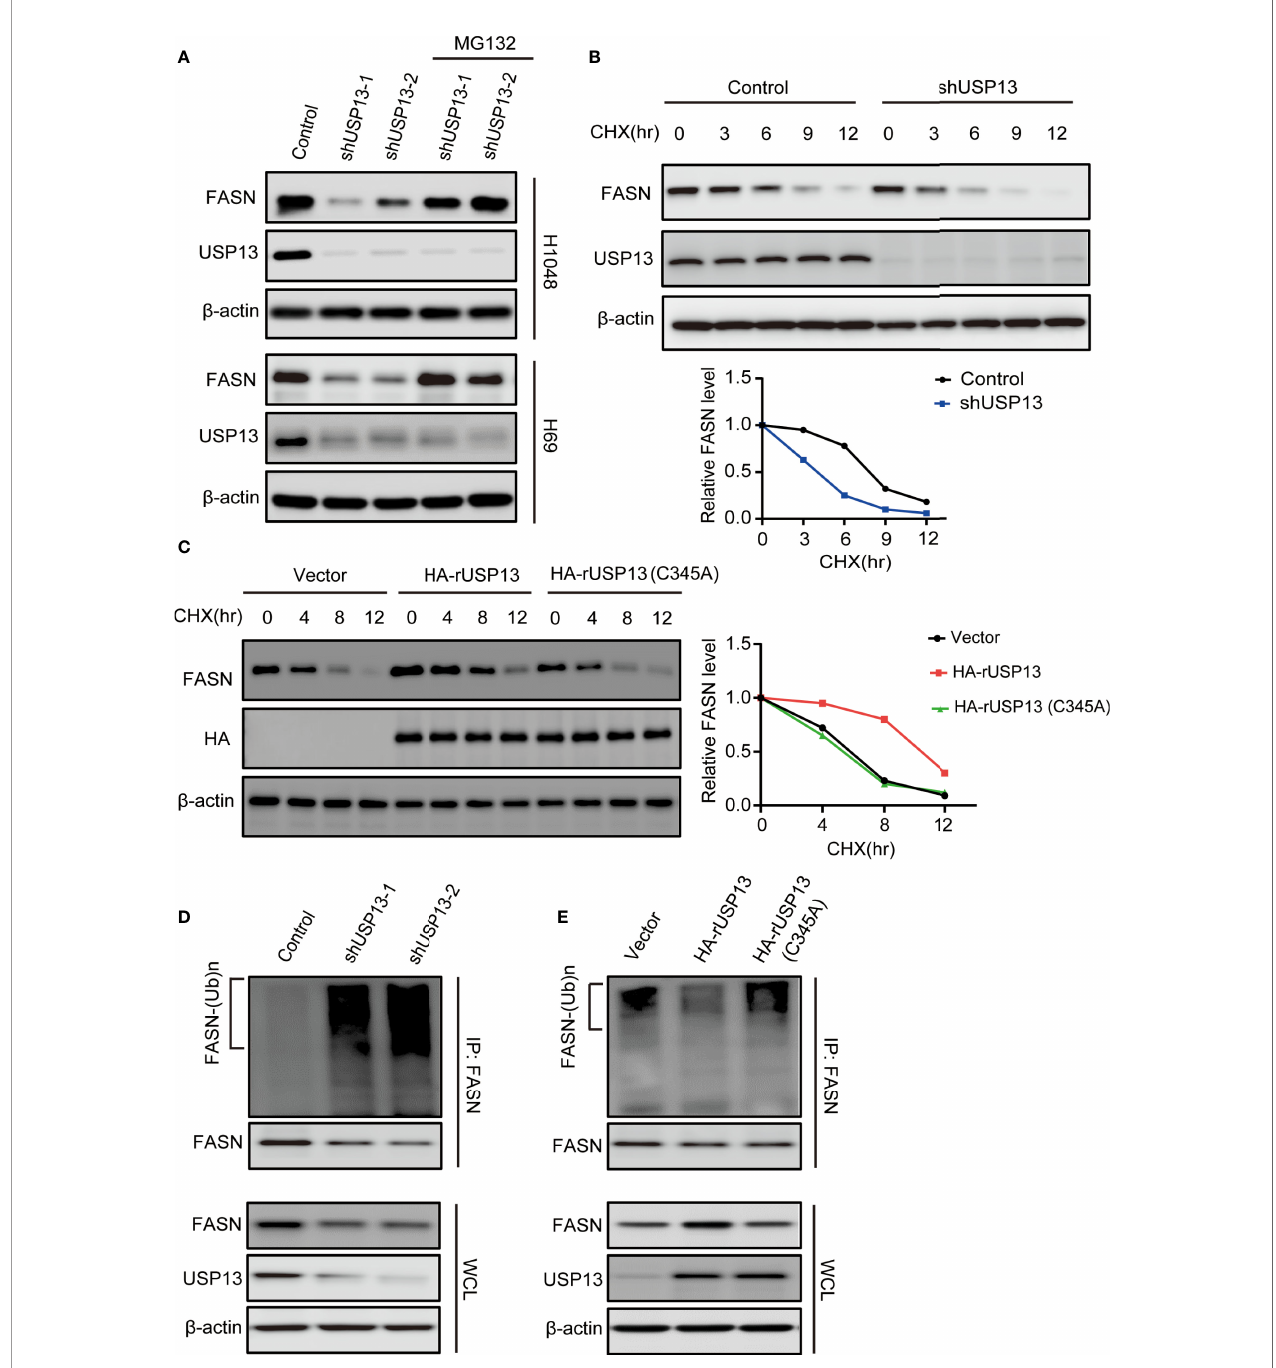
FIGURE 4 | USP13 inhibits polyubiquitylation-dependent FASN degradation. (A) H1048 (upper) and H69 (lower) cells expressing two different USP13 shRNAs were treated with MG132 (50 m M) for 8 hours. Immunoblot analyses were performed with the indicated antibodies. (B) H1048 cells with or without USP13 depletion were treated with CHX (100 µg/ml) for the indicated periods of time. FASN expression levels were analyzed with an anti-FASN antibody (upper) and quanti fi cation of FASN levels relative to b -actin expression levels (lower) were performed. (C) H1048 cells with or without WT USP13 or catalytically inactive USP13 (C345A) mutant overexpression were treated with CHX (100 µg/ml) for the indicated periods of time. Immunoblot analyses were performed with the indicated antibodies (left). Quanti fi cation of FASN expression levels relative to b -actin expression levels is shown (right). (D) H1048 cells expressing two different USP13 shRNAs or a control shRNA were treated with MG132 (50 m M) for 8 hours. Immunoprecipitation and immunoblot analyses were performed with the indicated antibodies. (E) H1048 cells with or without WT USP13 or catalytically inactive USP13 (C345A) mutant overexpression were treated with MG132 (50 m M) for 8 hours. Immunoprecipitation and immunoblot analyses were performed with the indicated